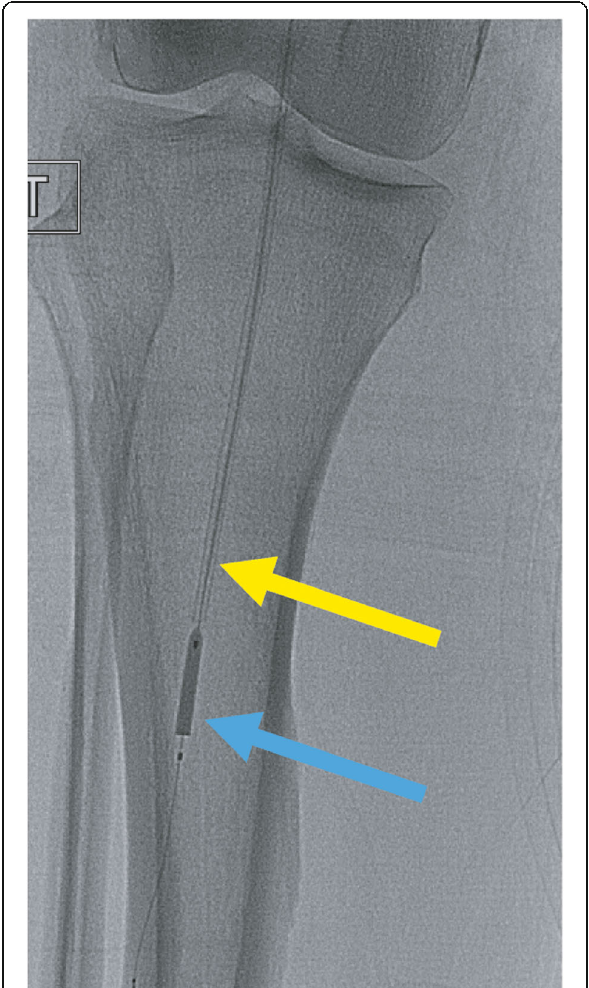
Fig. 6 Cannulation and capture of the catheter fragment (yellow arrow) using a partially inflated Sterling balloon past the end of the sheath fragment (blue